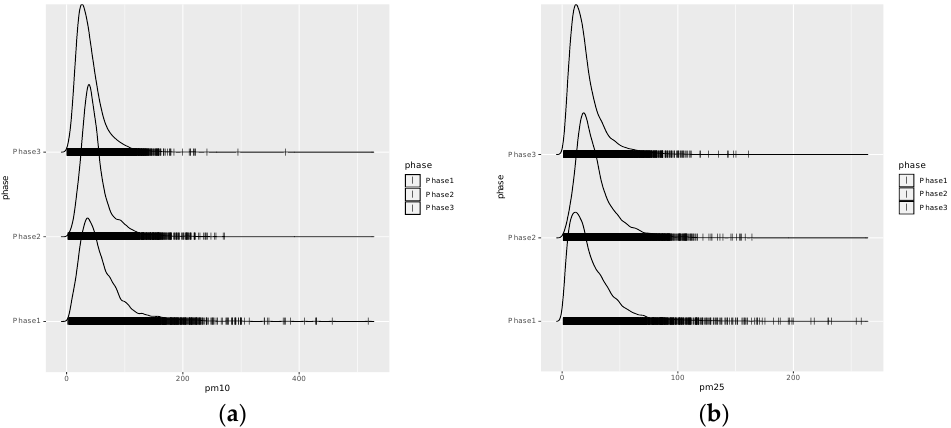
Figure 4. Probability density functions (PDFs) of PM 10 ( μ g/m 3 ) and PM 2.5 ( μ g/m 3 ) for Aksaray station with three Phases: ( a ) Aksaray station PM 10 ( μ g/m 3 ) PDFs for Phases 1 – 3; ( b ) Aksaray station PM 2.5 ( μ g/m 3 ) PDFs for Phases 1 – 3.